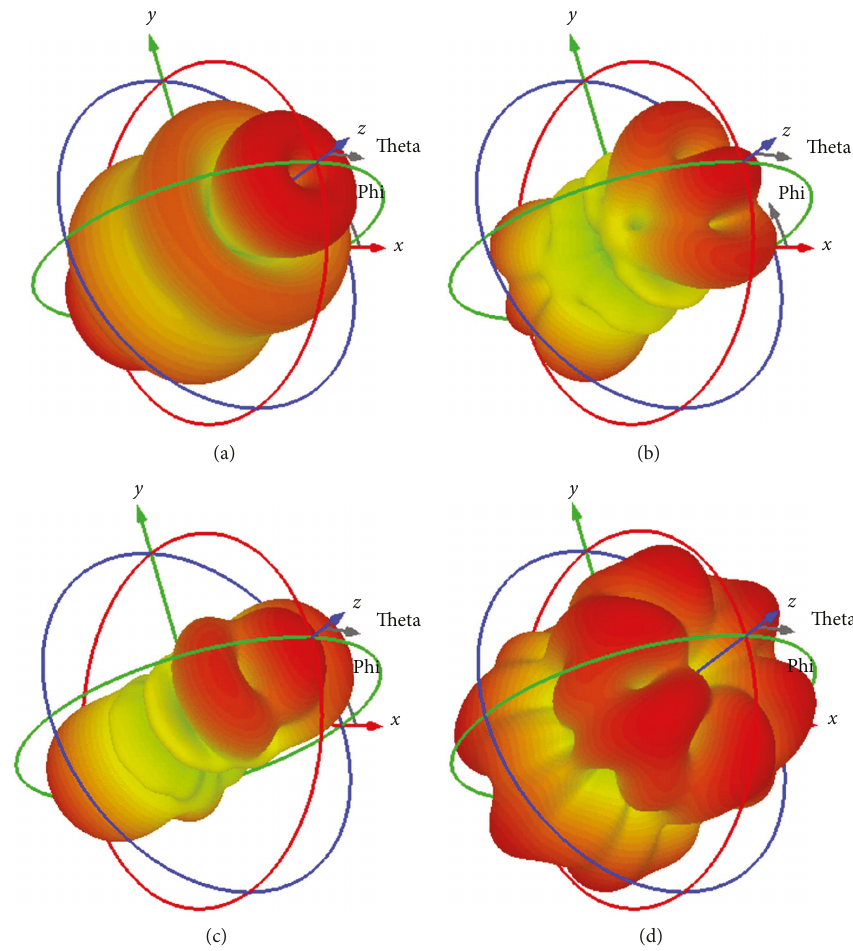
Figure 5: Modal radiation pattern of the proposed lens at 10 GHz. (a) mode 1, (b) mode 2, (c) mode 3, and (d) mode